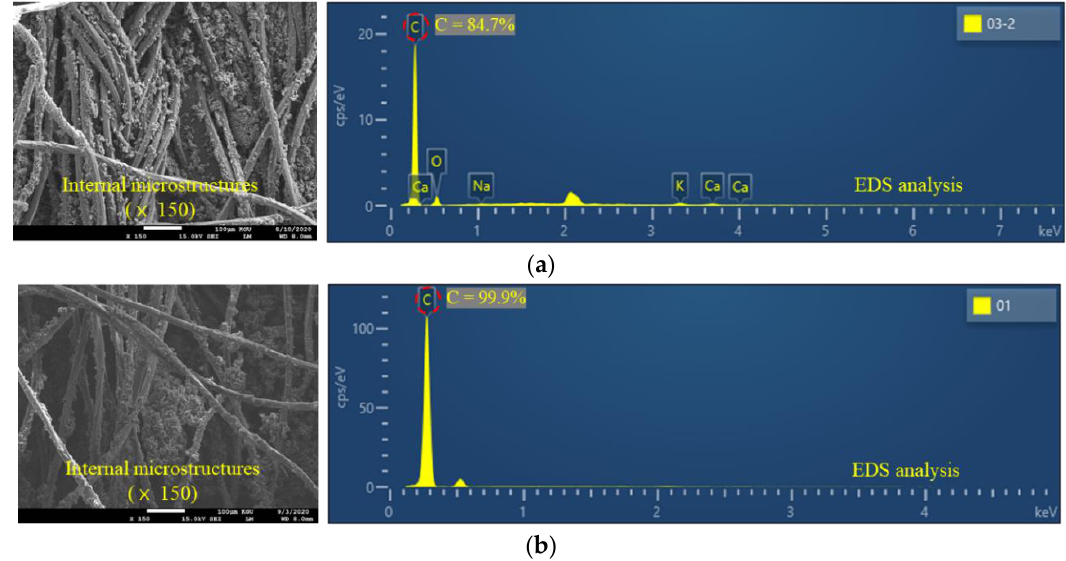
Figure 12. SEM images and EDS spectra of the uncoated textile fibers. ( a ) Before washing. ( b ) After 10 washing and one freeze–thaw cycle.